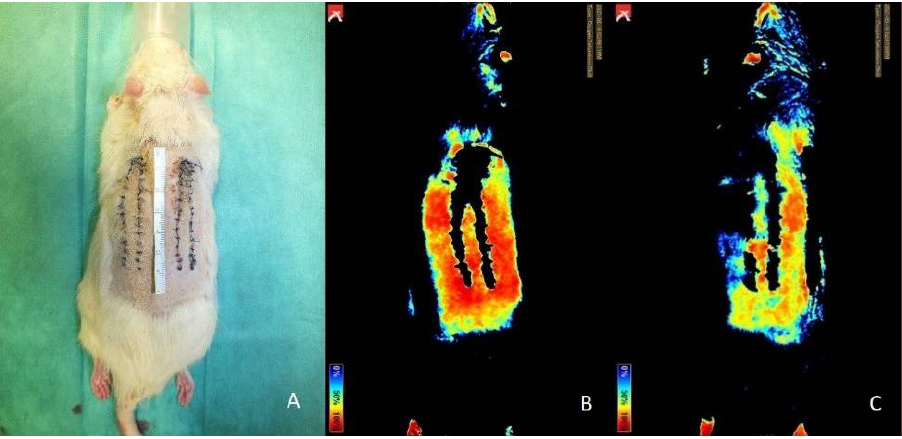
Figure 9. Group 2 comparison of clinical imaging ( A ) and near-infrared reflectance-based imaging at day 14: ( B ) right flap; ( C ): left flap.